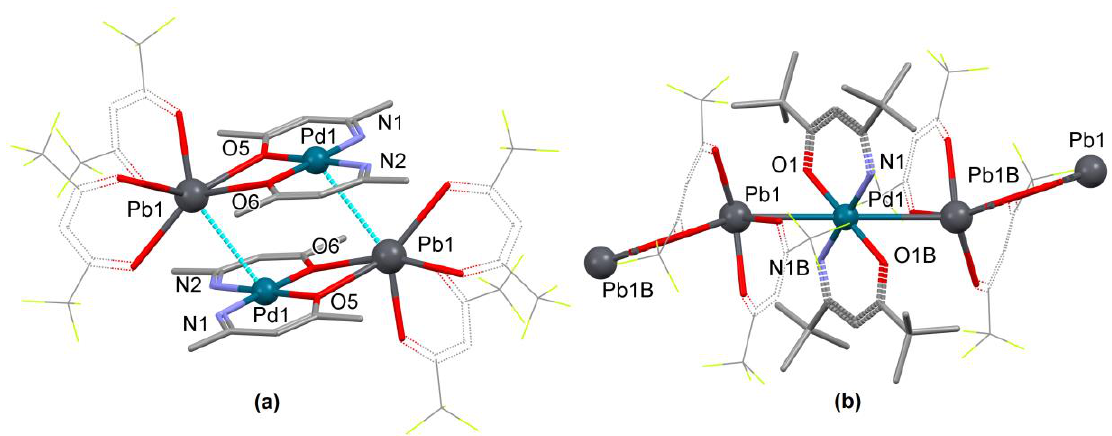
Figure 14. ( a ) Tetrameric (CSD Refcode HIJXEF) ( b ) and polymeric (CSD Refcode HIJWUU) structures based on metallophilic interactions with Pd–Pb distances of 3.551 and 3.459 Å, respectively [197].